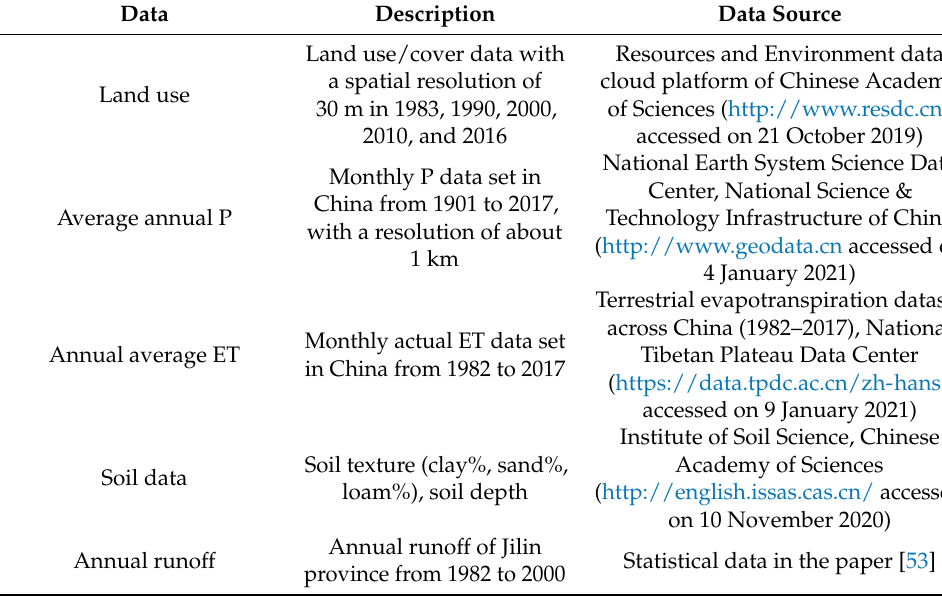
Table 1. The datasets used for simulating the change of water conservation.